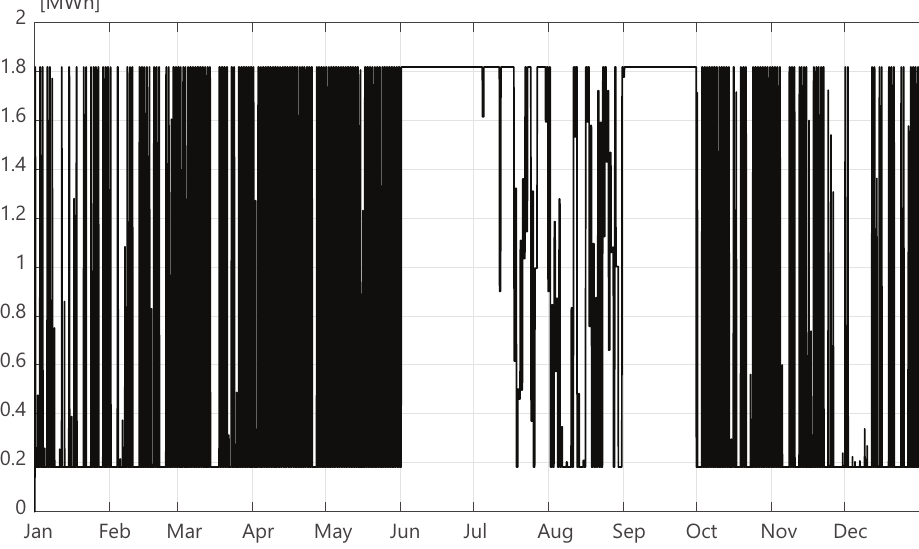
Figure 25. Simulation of the state of charge of the